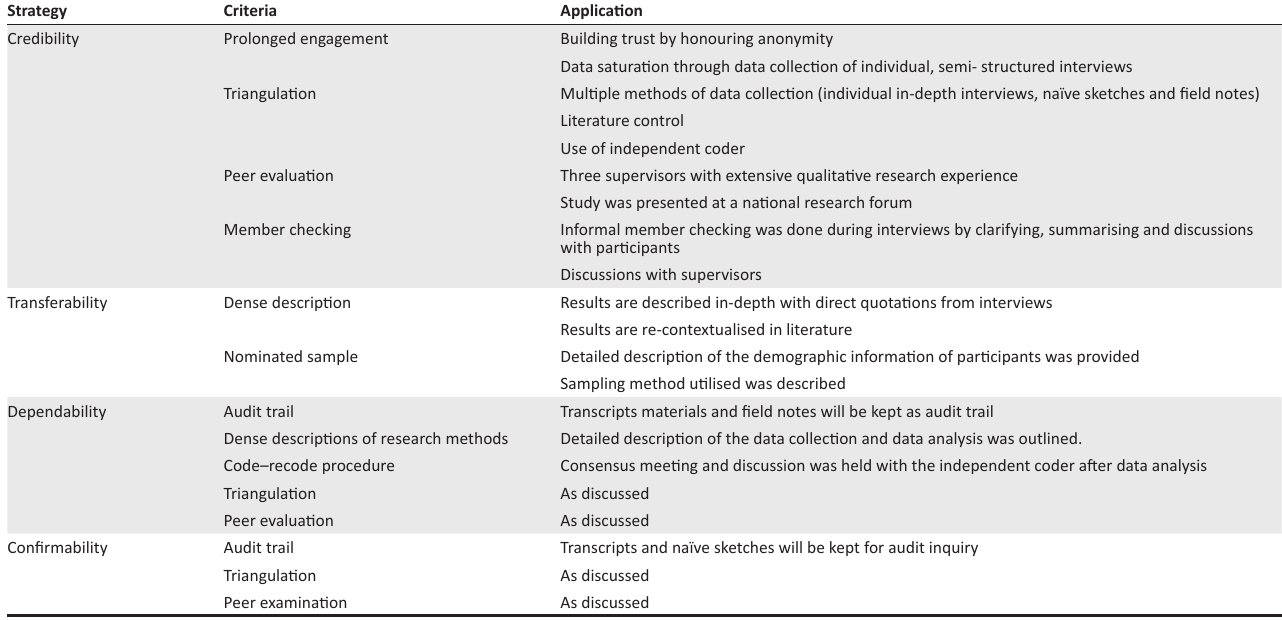
TABLE 1: Trustworthiness strategies applied in the study.